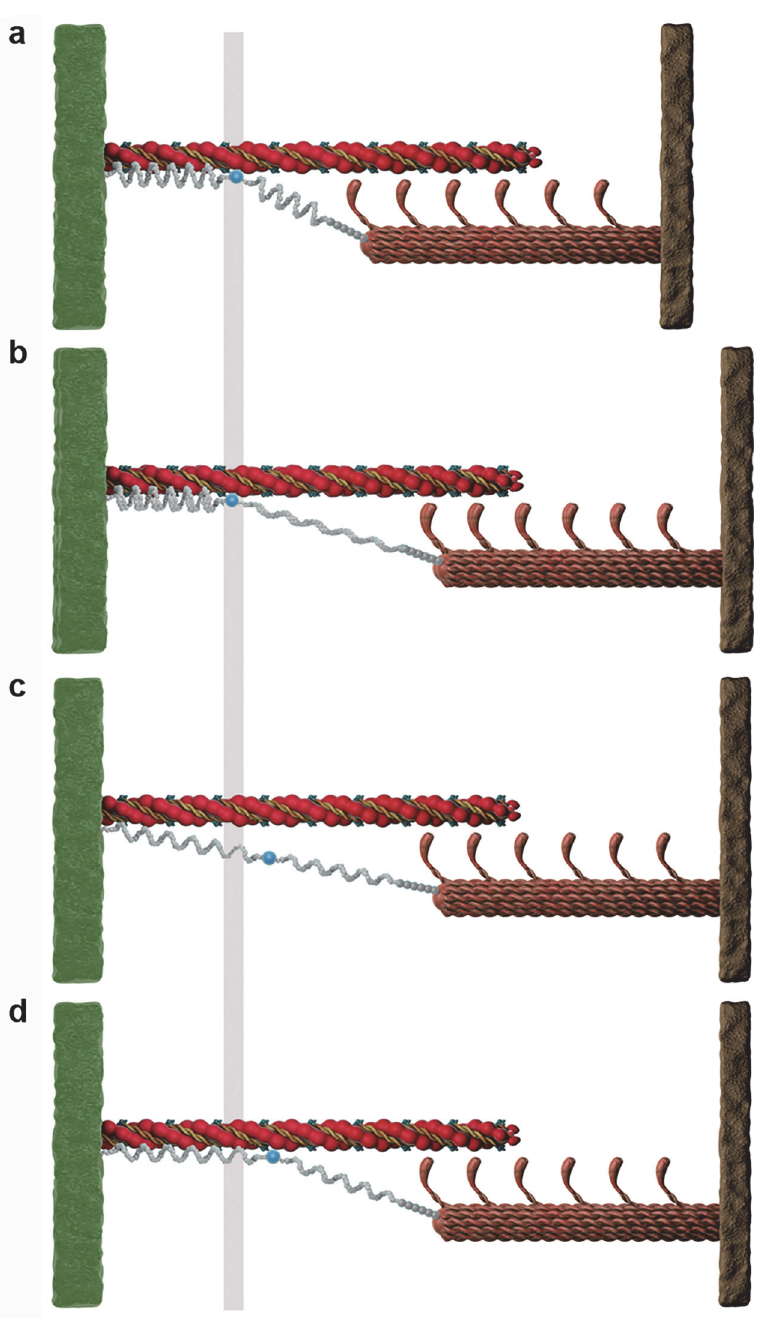
Fig 5. Illustration of an active stretch of a sarcomere based on the three filament model. a, The sarcomere is activated at a length of 2.4 μ m and b, stretched to 3 μ m. The resulting force is compared to the corresponding isometric force at 3 μ m where the sarcomere is activated at a length of 3 μ m and the elongation of titin ’ s free spring length is less compared to b independent of whether titin is attached to actin d or not c .